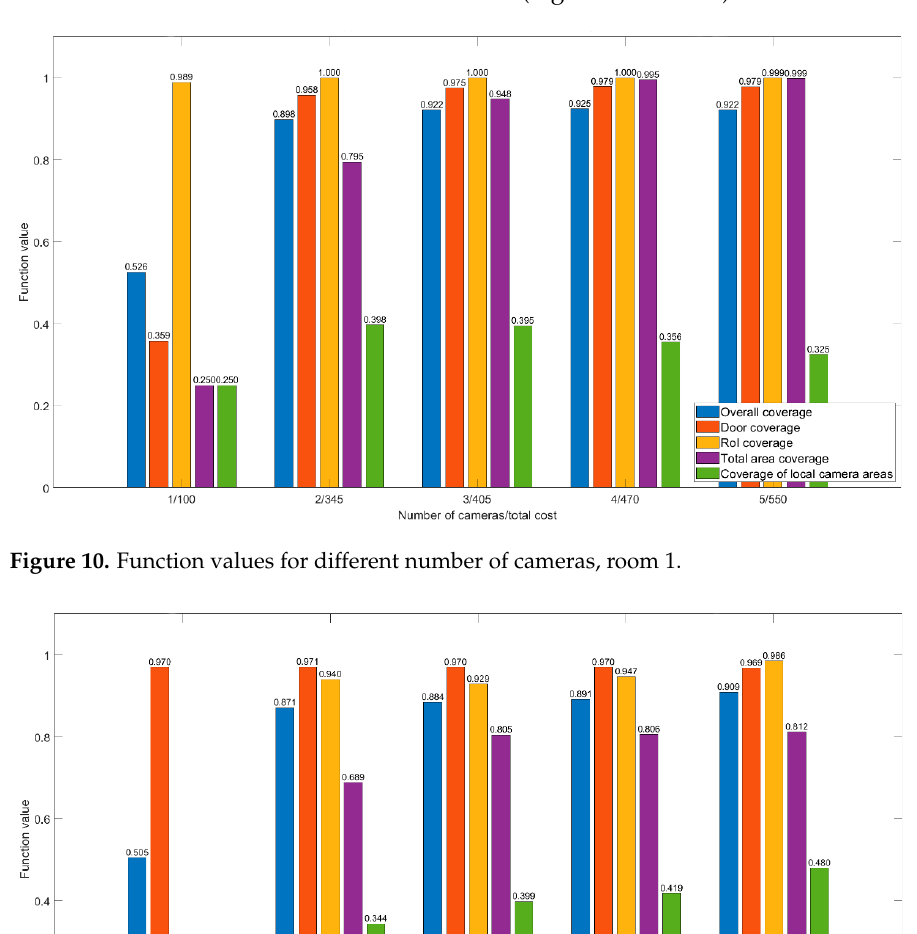
( d ) Figure 12. Placement of cameras in room 1: ( a ) room 1 model; ( b ) single camera placement; ( c ) placement of two cameras; and ( d ) placement of three cameras. Figure 10 shows a comparison diagram of the different number of cameras for the first room. It is apparent that one camera is enough to fully cover the RoI, and one door also falls into the camera ’ s view area, as shown in Figure 12b. To cover all the doors in the